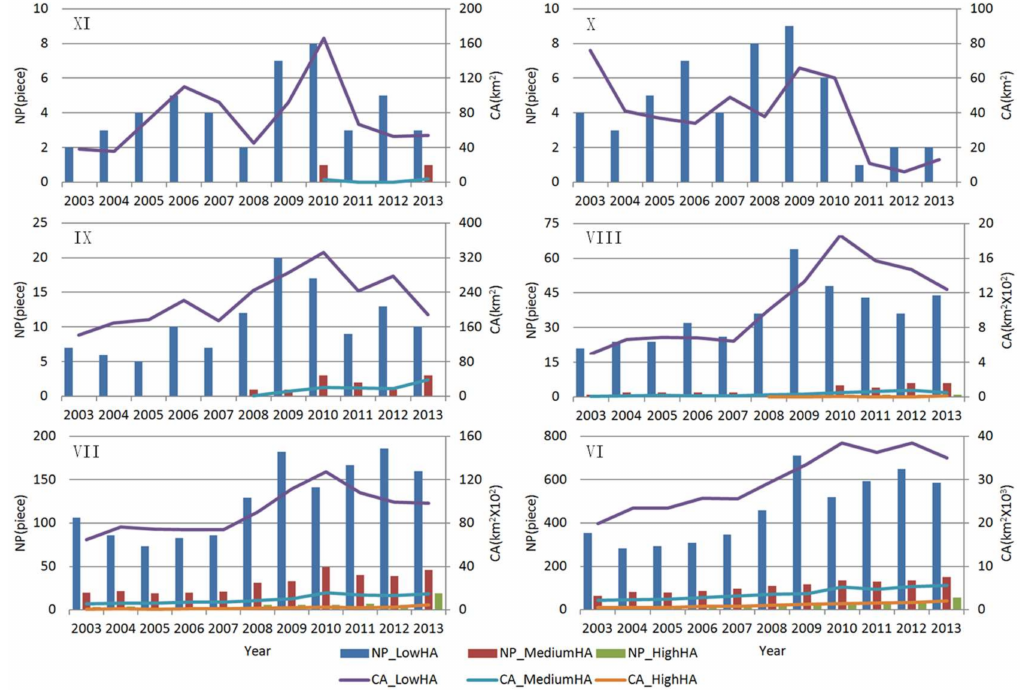
Figure 10. The statistic of human activity spatiotemporal pattern in the study